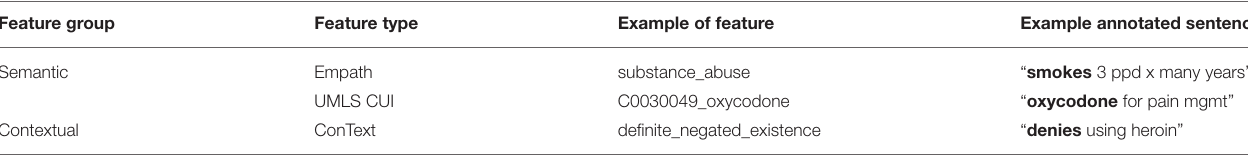
TABLE 1 | Feature types used to train and test supervised classifiers, with examples of features and related annotation sentences. Feature